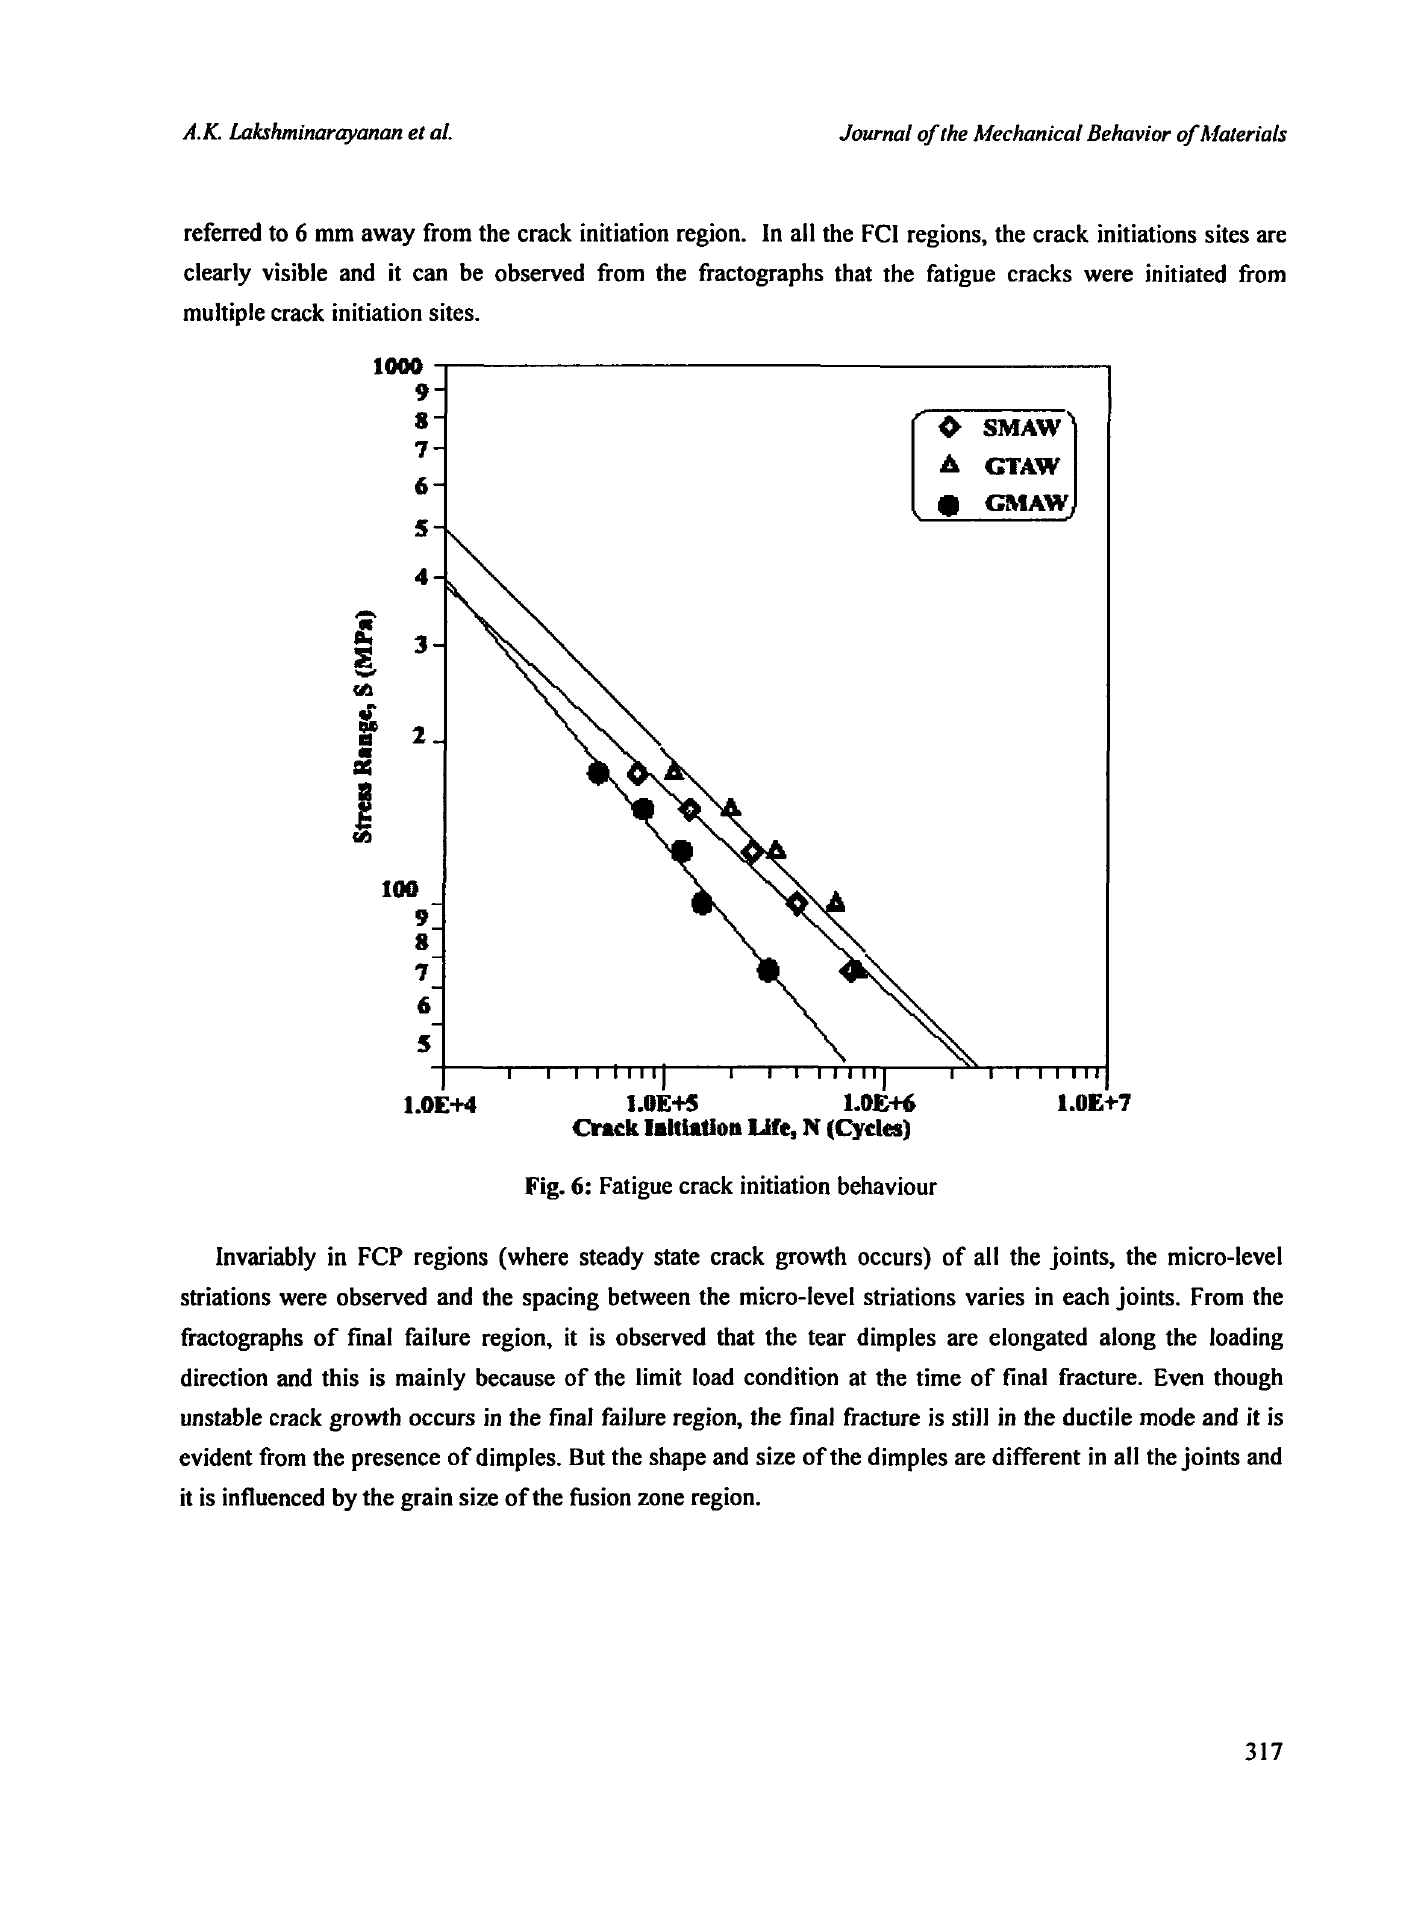
Fig. 6: Fatigue crack initiation